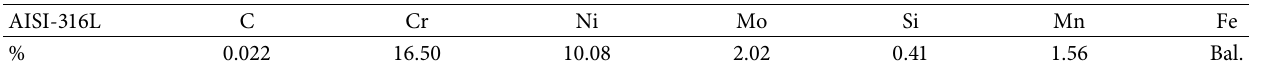
Figure 11: Chromium Ka source X-ray difraction pattern of AISI316L, WC :C DLC coating, and ASPN+DLC coatings at 350 ° C, 400 ° C, and 450 ° C. Table 3: AISI316L chemical composition.